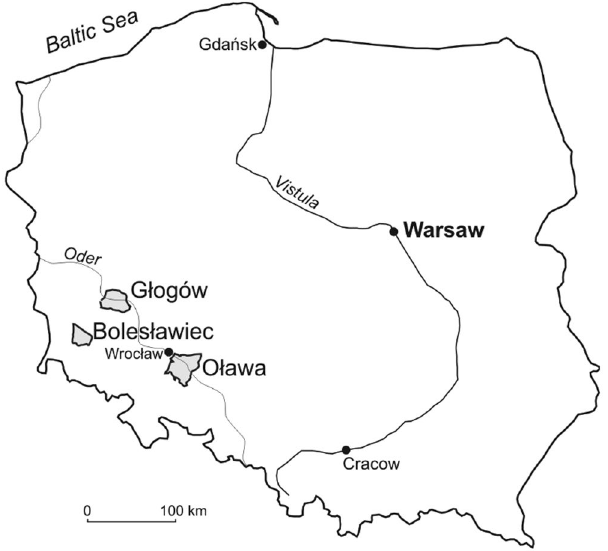
Figure 2. Forests included in the present study (Puchałka unpubl. using DIVA GIS 7.5, http://www.diva-gis. org/).